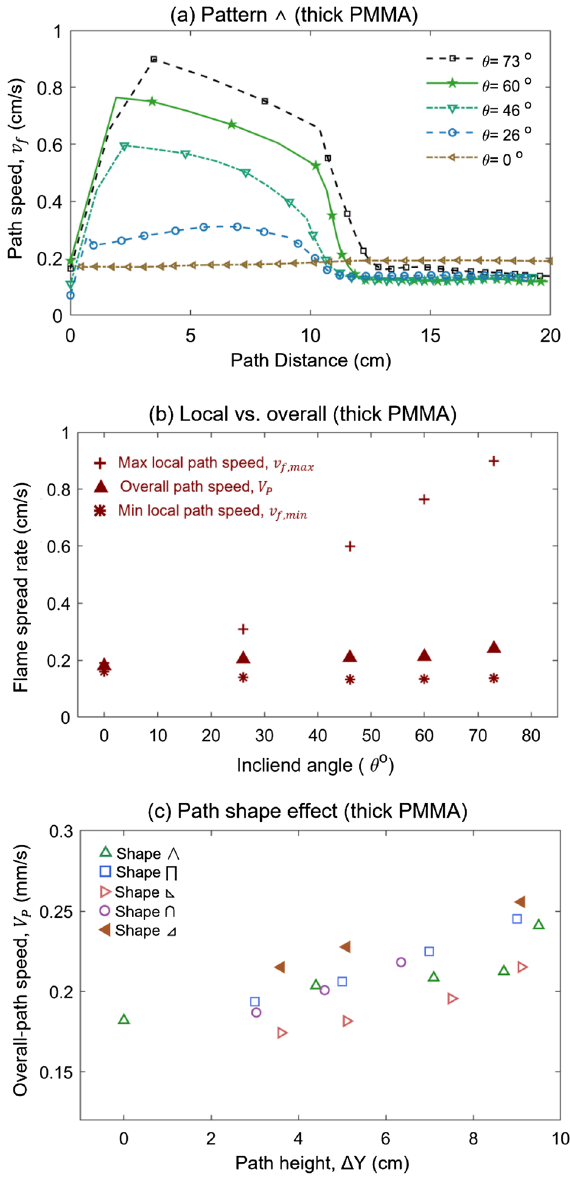
Figure 10. Fire spread rate on 5-mm thick PMMA bar, ( a ) local fire speed ( v f ) with different inclined angles, ( b ) overall fire spread rate ( V P ) vs. local maximum ( v f , max ) and minimum ( v f , min ), and ( c ) overall fire spread rate ( V P ) all path